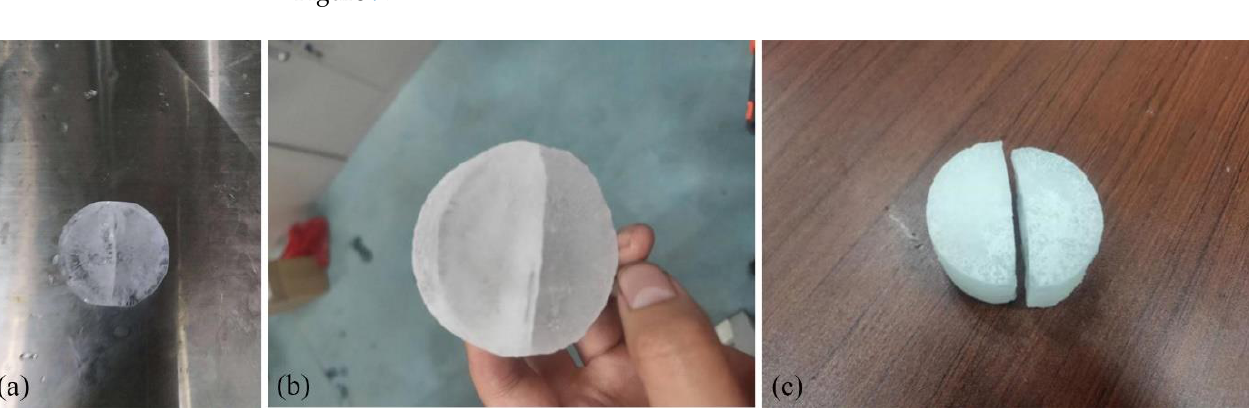
Figure 16. Ice mold for Brazilian disc splitting test. ( a ) Ice sample were frozen and shaped in the ice mold. ( b ) Ice mold.